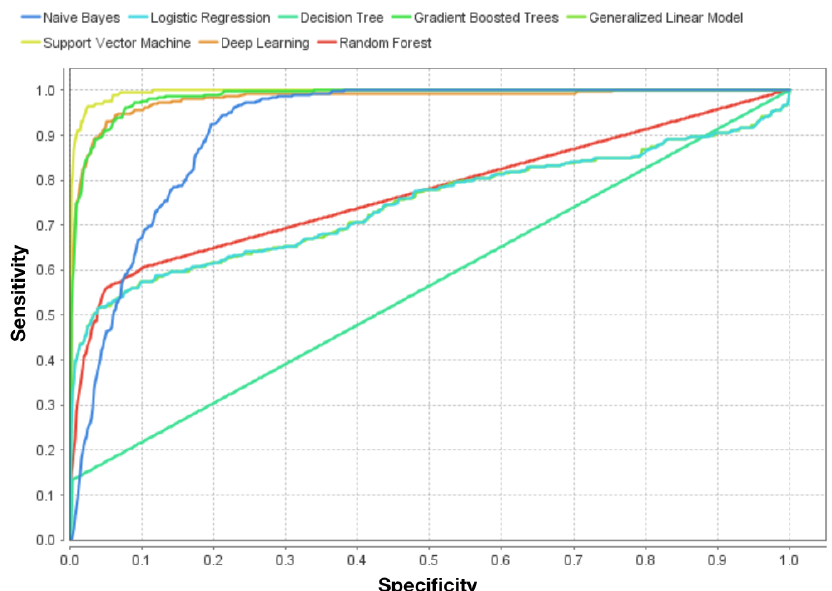
Figure 4. ROC—Classification process effectiveness—Data witout similarity metrics on the data set. Comparison—Naive Bayes, Logistic Regression, Decision Tree, Gradient Boosted Tree, Generalized Linear Model, Deep Learning, Random Forest.